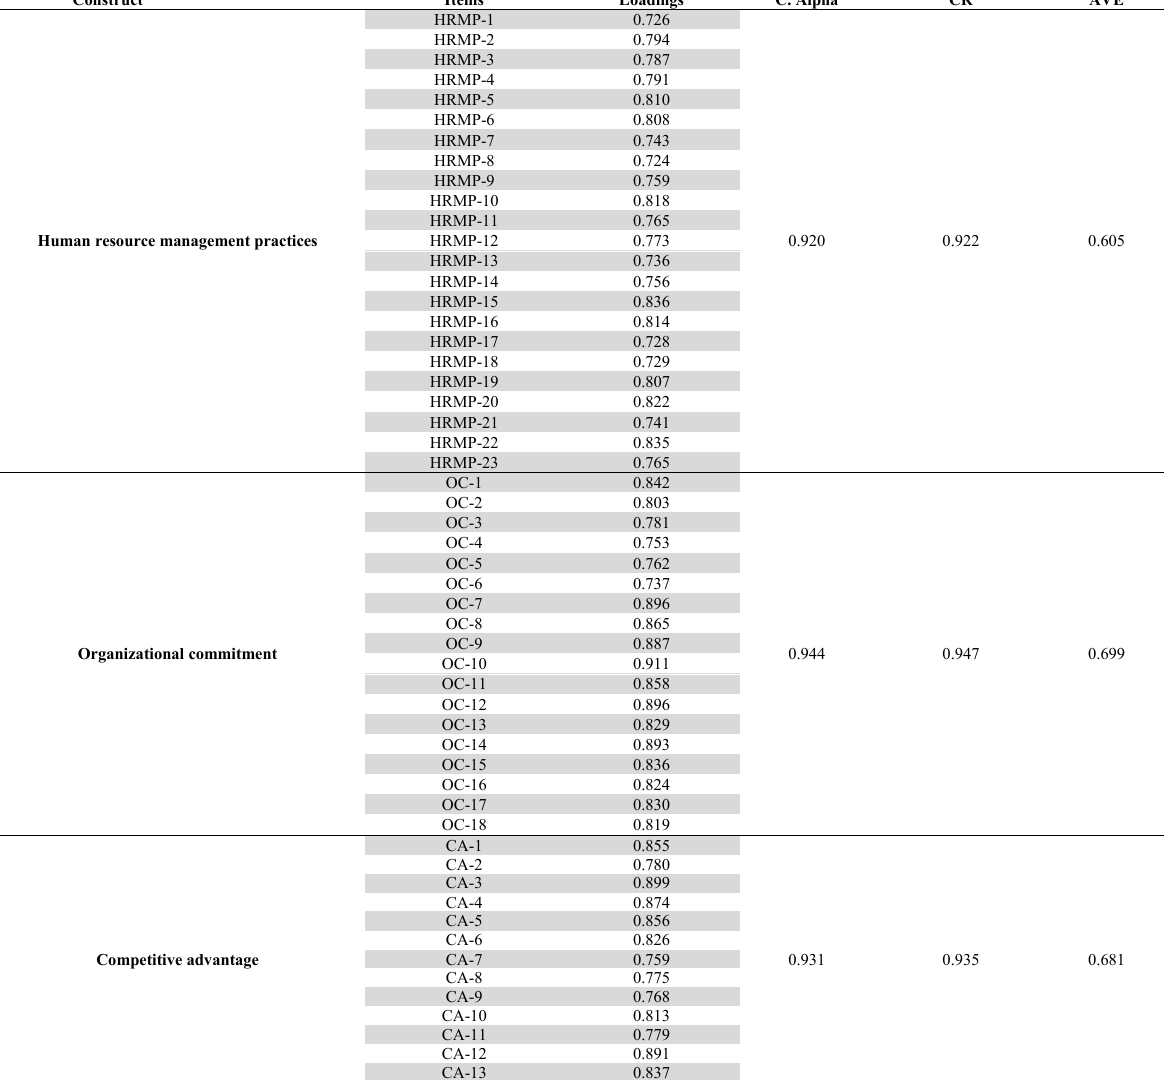
Measurement model Construct